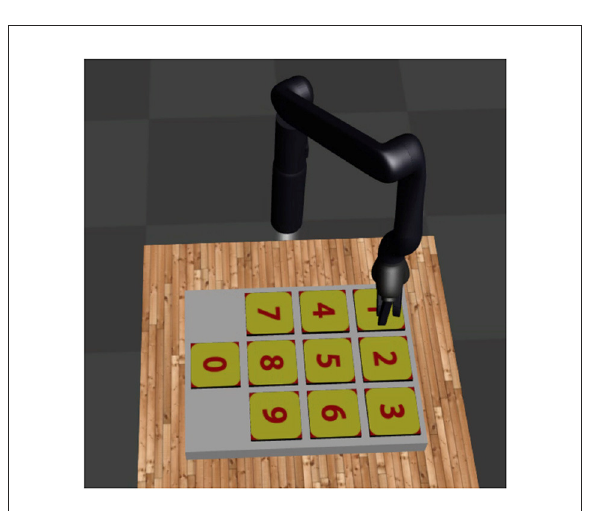
FIGURE8 The joint-domain dial scenario. A Jaco manipulator modeled in Mujoco presses a sequences of four keys on a dialpad. The positions of the keys are randomly shuffled for each demonstration. The positions of the joints and positions of the keys are given as state information.